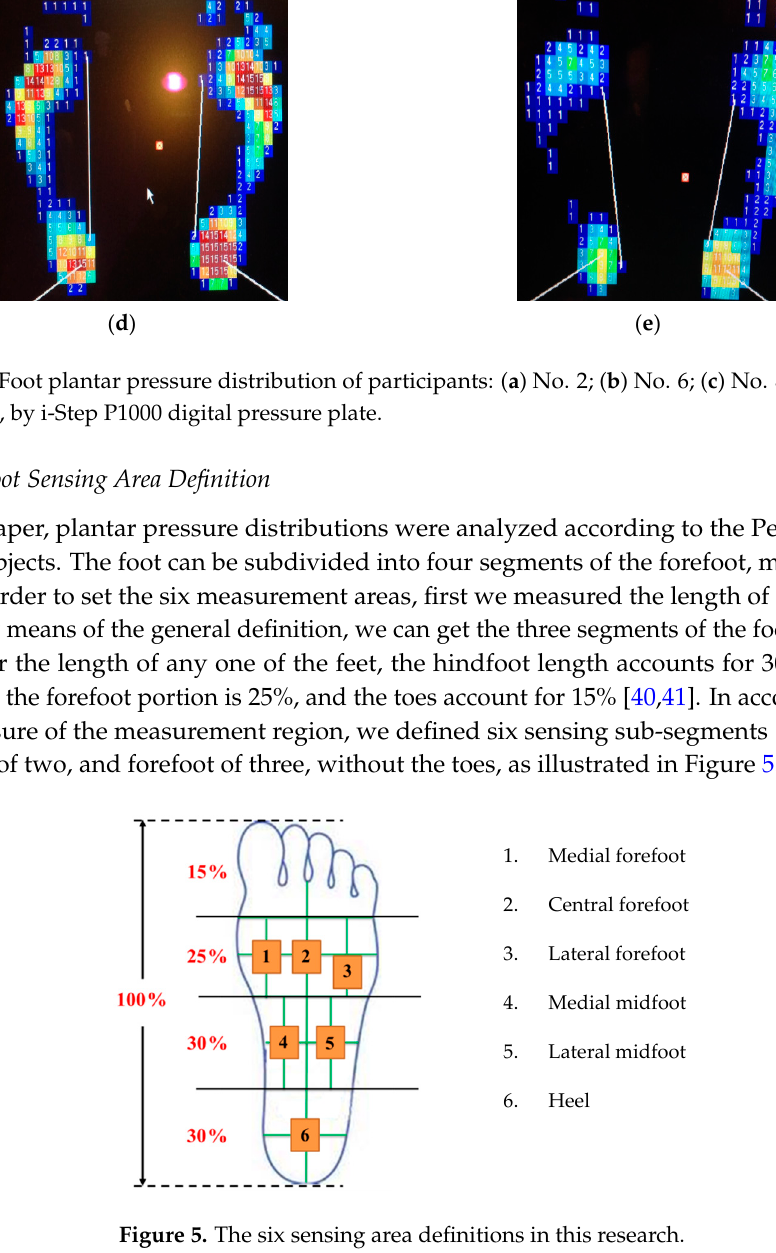
Figure 5. The six sensing area definitions in this research.